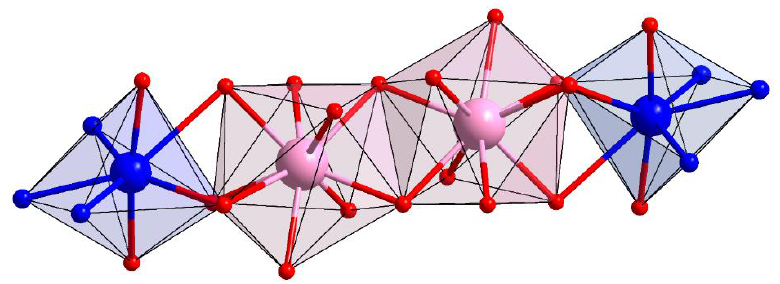
Figure 5. Coordination polyhedra of metal atoms in 4.